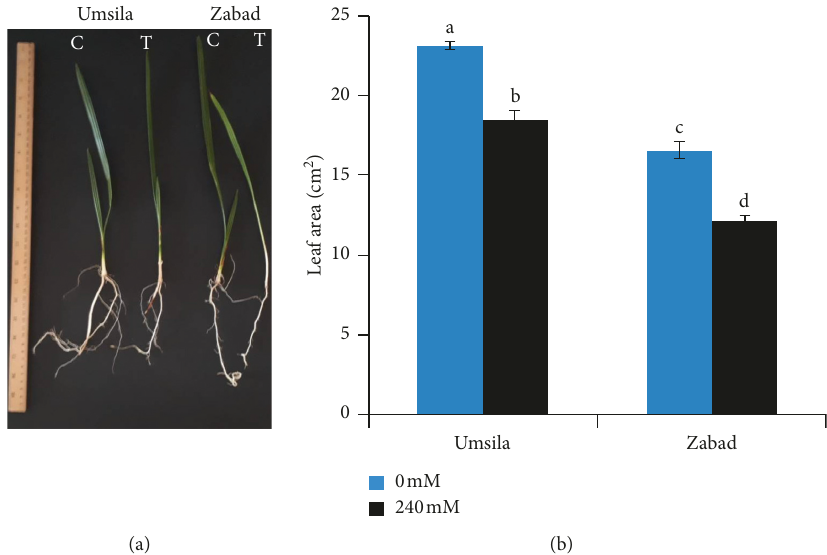
Figure 1: Seedlings phenotype (a) and leaf area (b) of Umsila and Zabad date palm cultivars grown under control and salt stress (240 mM NaCl) conditions. Bars represent mean ± SE ( n � 3). Statistical differences between the treatments were calculated based on ( p ≤ 0 .